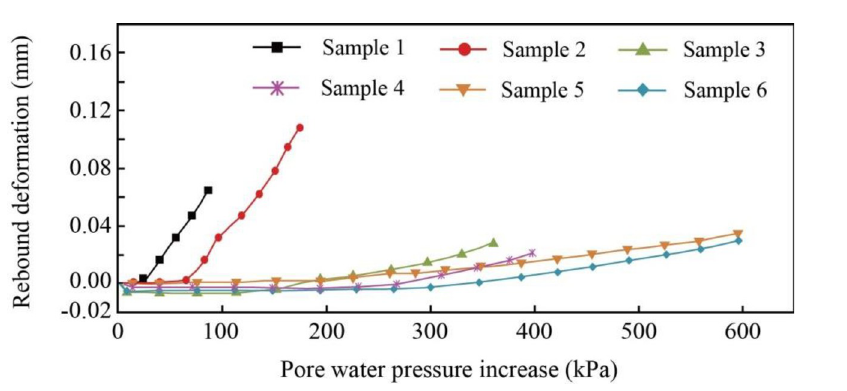
Fig 8. Rebound deformation with increasing pore water pressure for each soil sample.